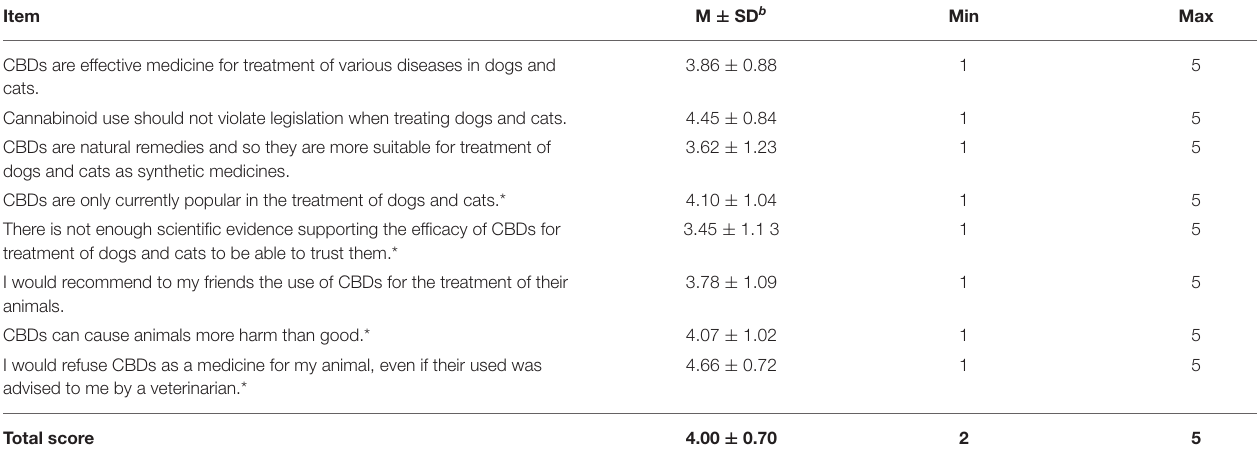
TABLE 1 | Descriptive statistics for each of the items and total score of the short scale of attitudes toward cannabinoids (CBDs) a . Item M ± SD b Min Max CBDs are effective medicine for treatment of various diseases in dogs and cats.